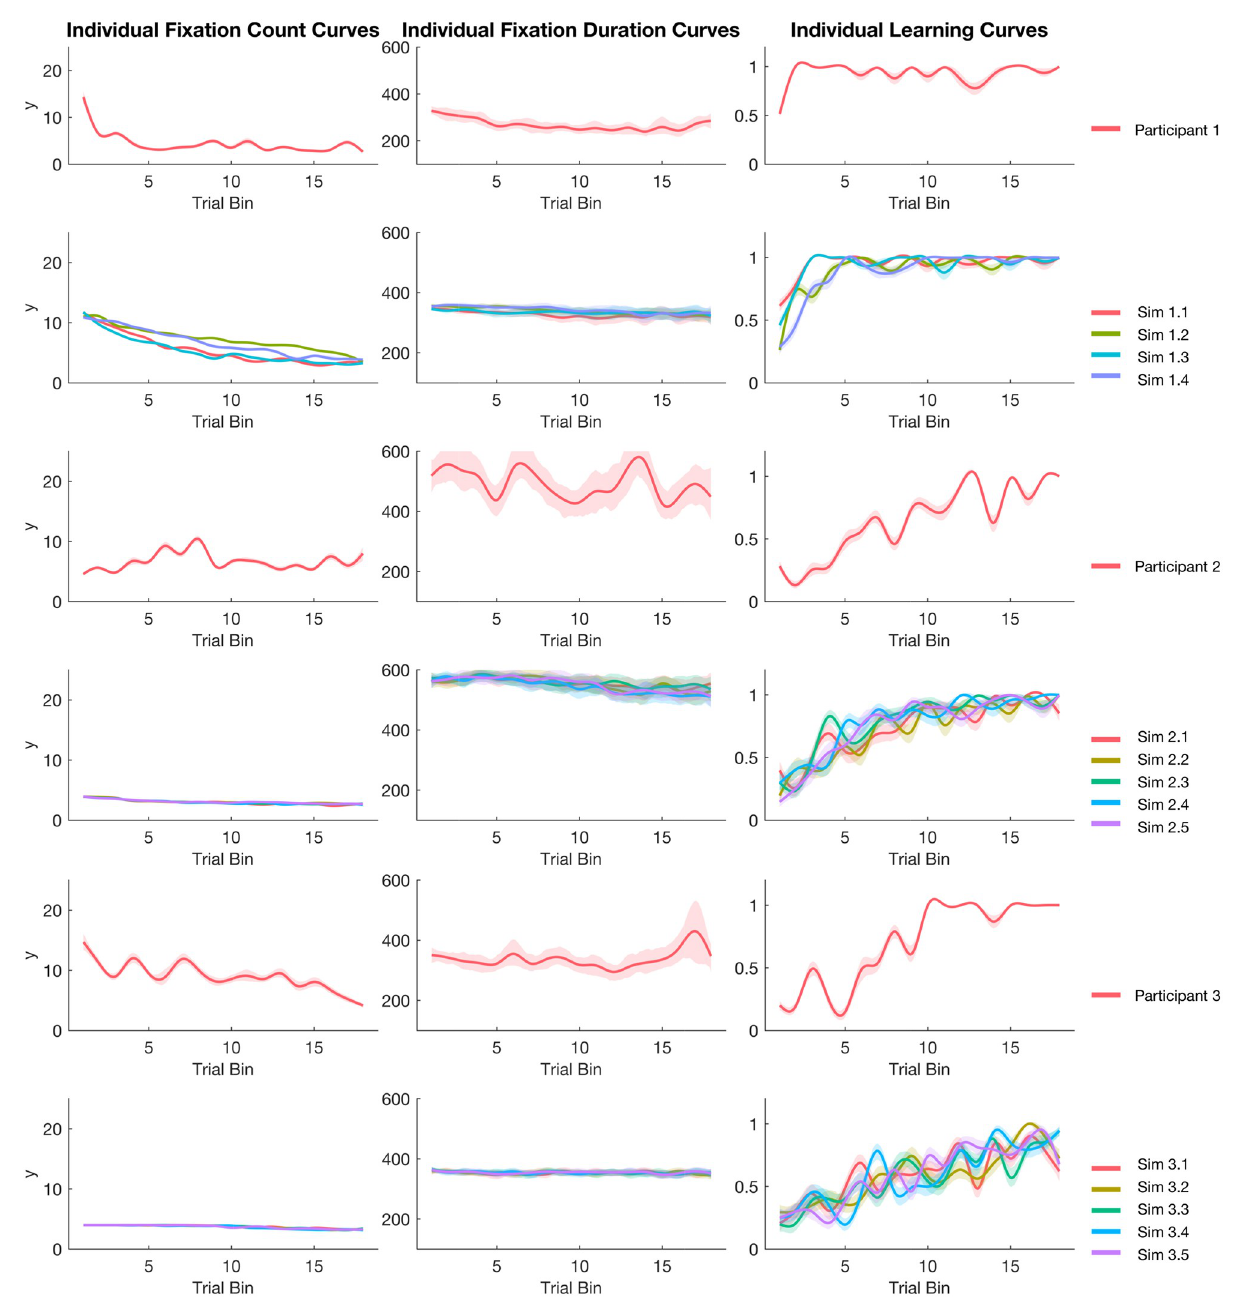
Fig 8. Simulation 2: Experiment and model stimuli examples. A) Example stimulus used by [10]. The four features of interest were reported to subtend approximately 4˚ of visual angle each, with the stimulus height and width being 12˚. B The four color features, spaced 24 spatial units horizontally and vertically and 34 spatial units diagonally, presented to the